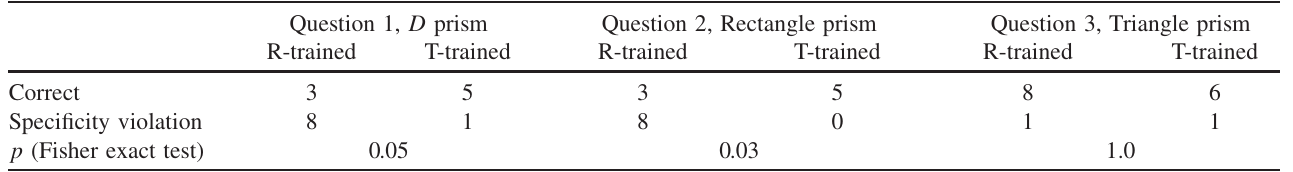
TABLE IV. Evidence of specificity in algebra